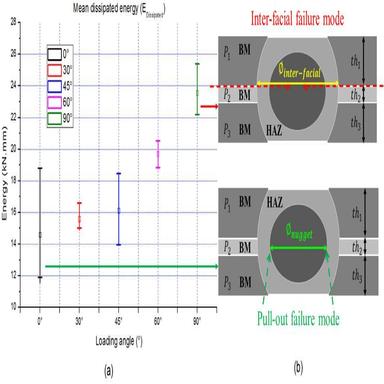
(a) Effect of the loading angle on the mean dissipated energy. (b) Illustrative scheme of the two failure modes.